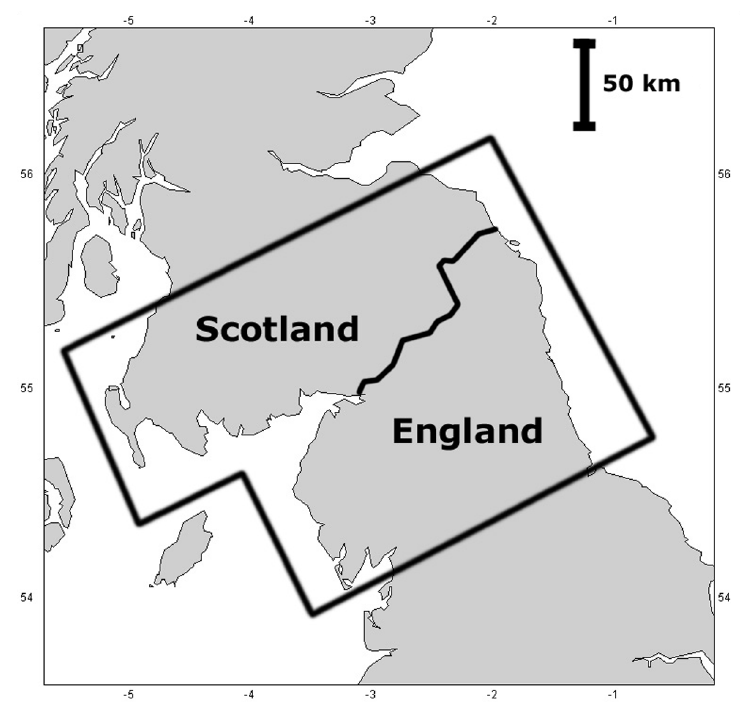
Fig. 1. The study area for this